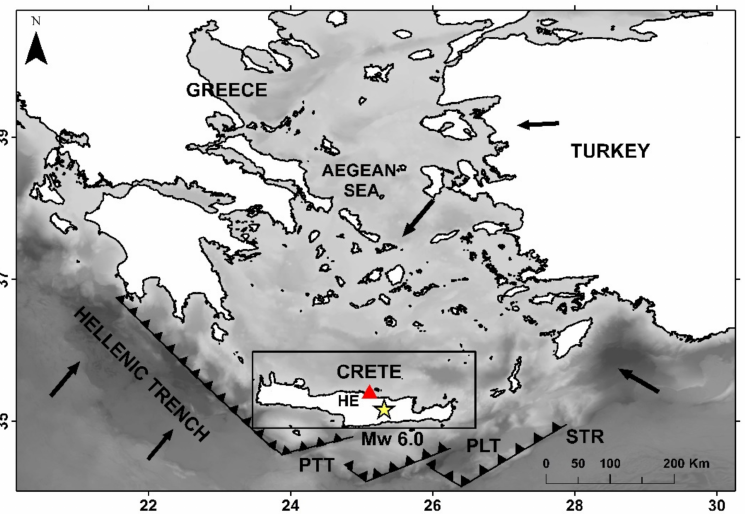
Figure 1. Seismotectonic setting of the study area [1,2]. Key: rectangle shows the Crete area illustrated in Figures 2 and 3; arrows show lithospheric plate motions; the African (Nubian) lithosphere subducts from the Mediterranean underneath the Aegean Sea at the southern Eurasian plate margin along the Hellenic Trench system e.g., [3]; PTT, PLT and STR stand for Ptolemy, Pliny and Strabo trenches, respectively; star shows the epicenter of the M w 6.0 27 September 2021 mainshock; red triangle stands for Heraklion (HE), the capital city of Crete.